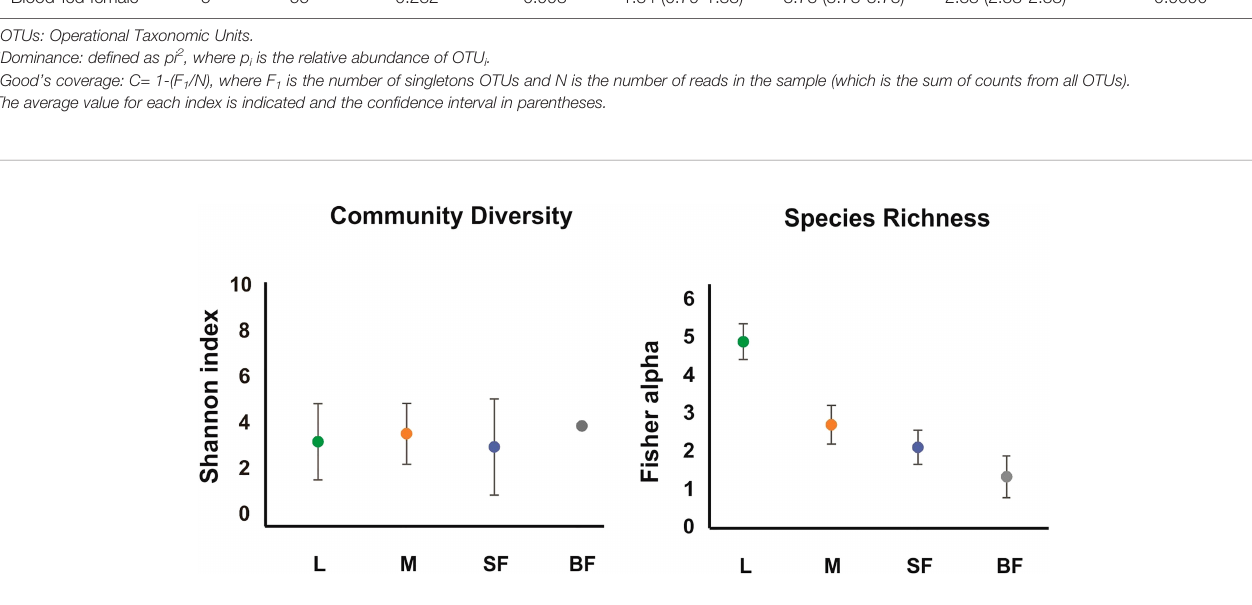
FIGURE 1 | Alpha diversity of the fungal communities along Cx. quinquefasciatus development. The alpha-diversity was estimated with diverse indexes for different instars. The Fisher_alpha, and Shannon indices are represented in the graphs. L, larvae; M, sucrose-fed male; SF, sucrose-fed females; BF, blood-fed females. The error bars represent the 95% con fi dence interval, obtained with a randomization of 100 runs and sampling with replacement.